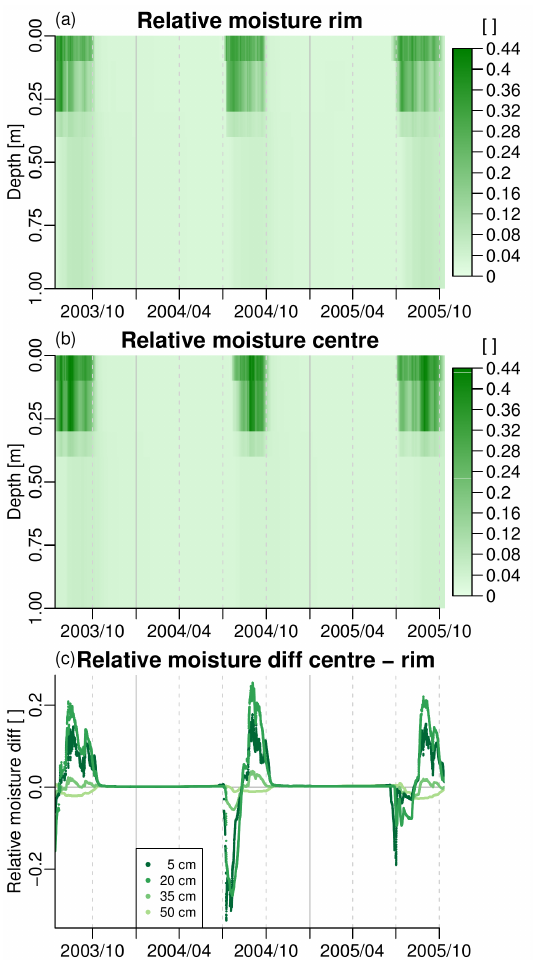
Figure B1. Modelled relative soil moisture content of the upper- most metre at the (a) rim and (b) centre as well as (c) the difference centre minus rim in several depths. Solid lines indicate 1 January; dashed lines indicate 1 April, 1 July and 1 October of the respective year. The scale maximum for (a) and (b) is field capacity, ceiled to two digits.